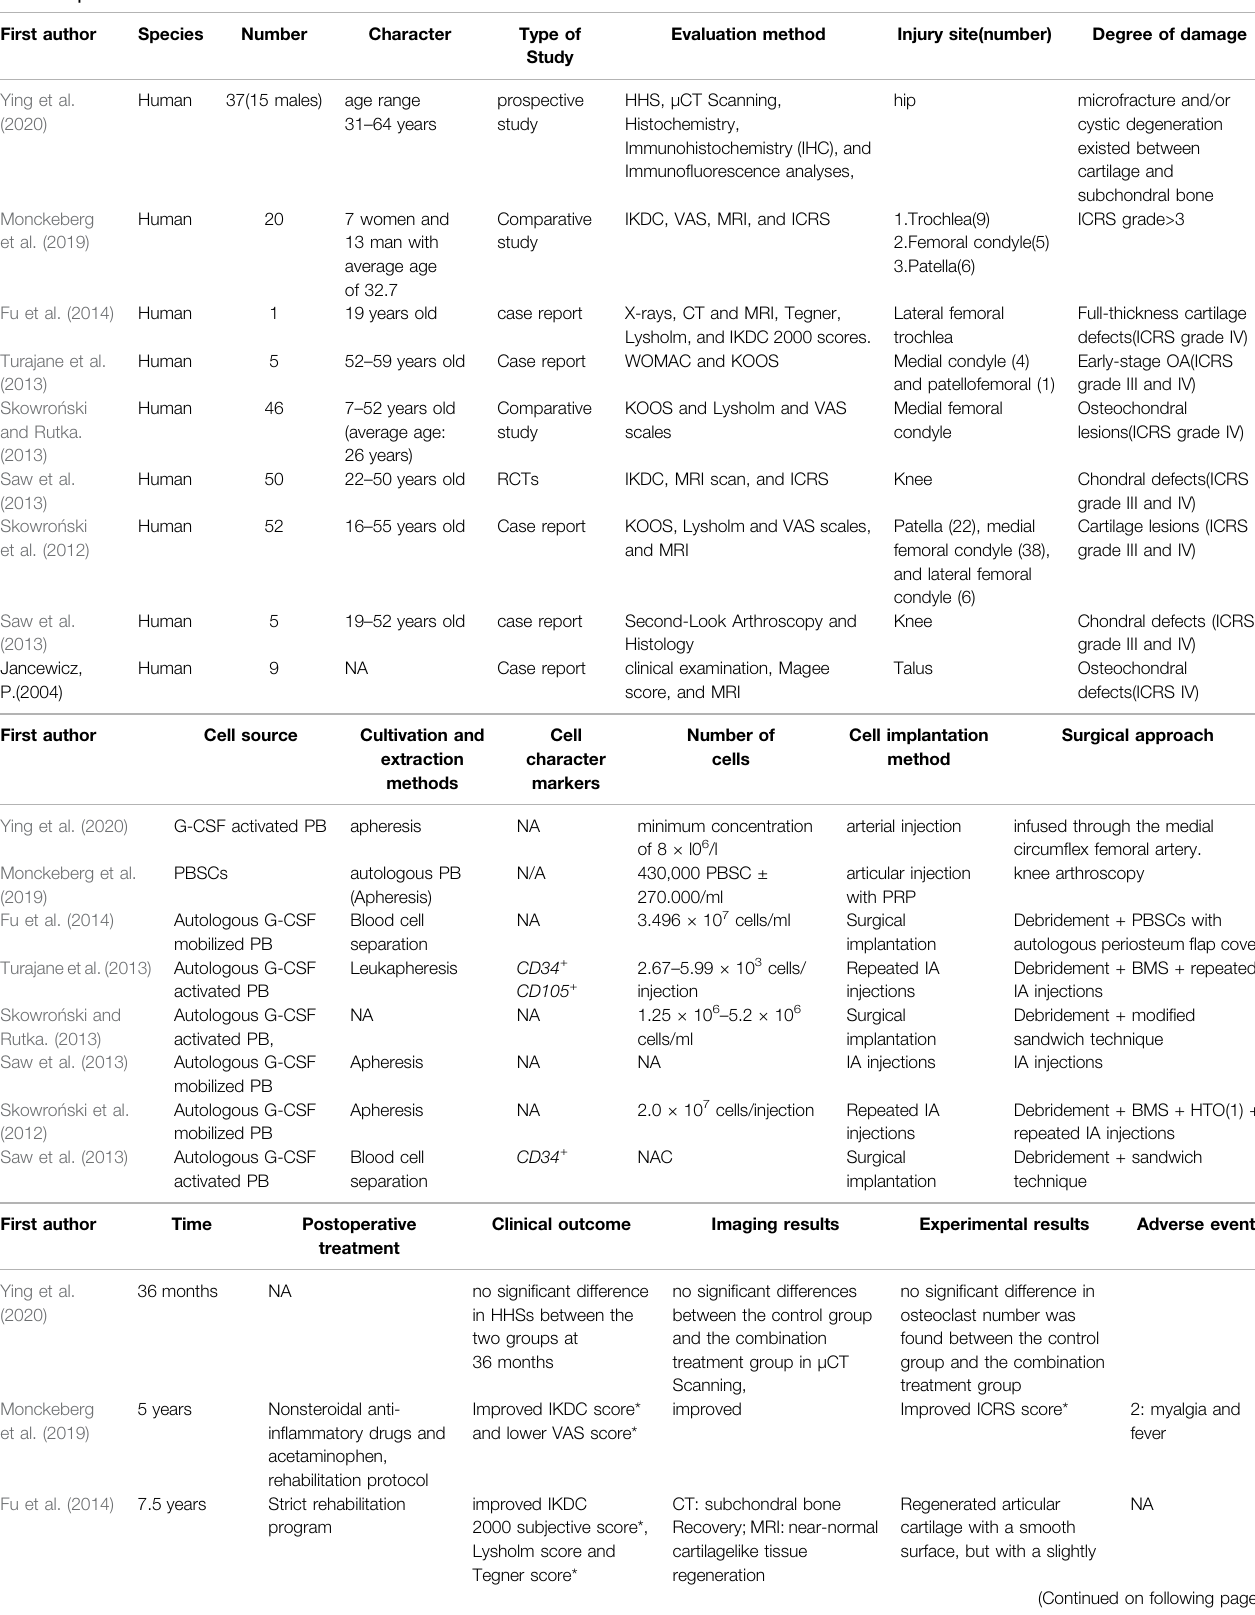
TABLE 2 | PBSCs in